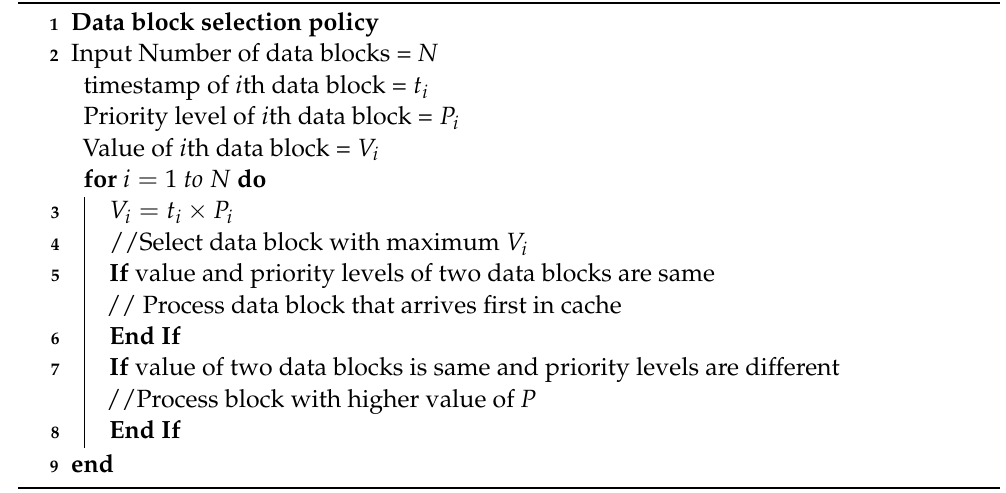
Algorithm 2: Pseudo code of nonce computing by mining